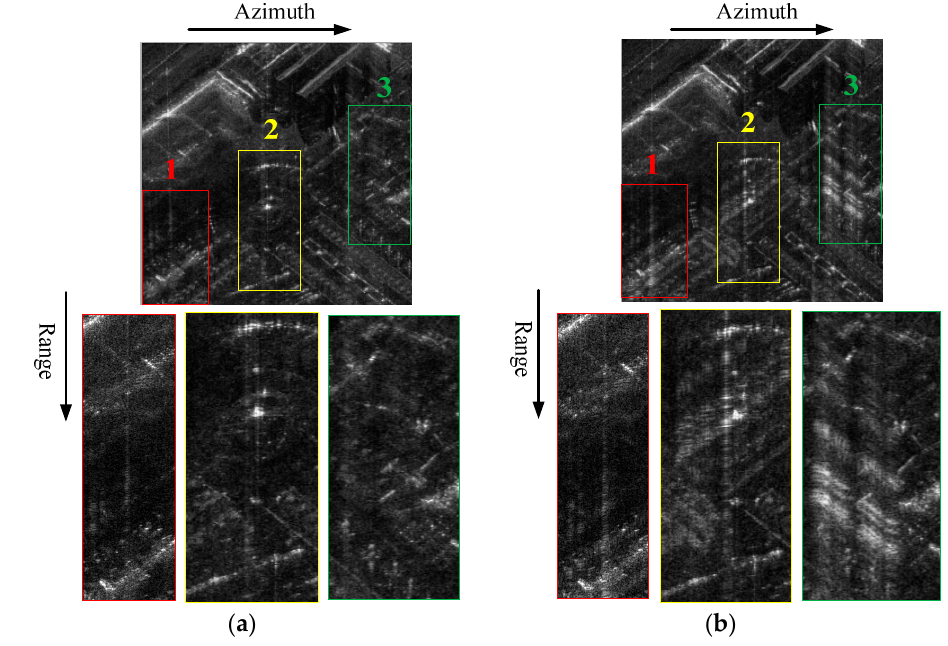
Figure 7. Stepped-frequency SAR image after GLS: ( a ) by the proposed method; and ( b ) by the contrast-based phase error estimation method combined with a spectral density equalization.